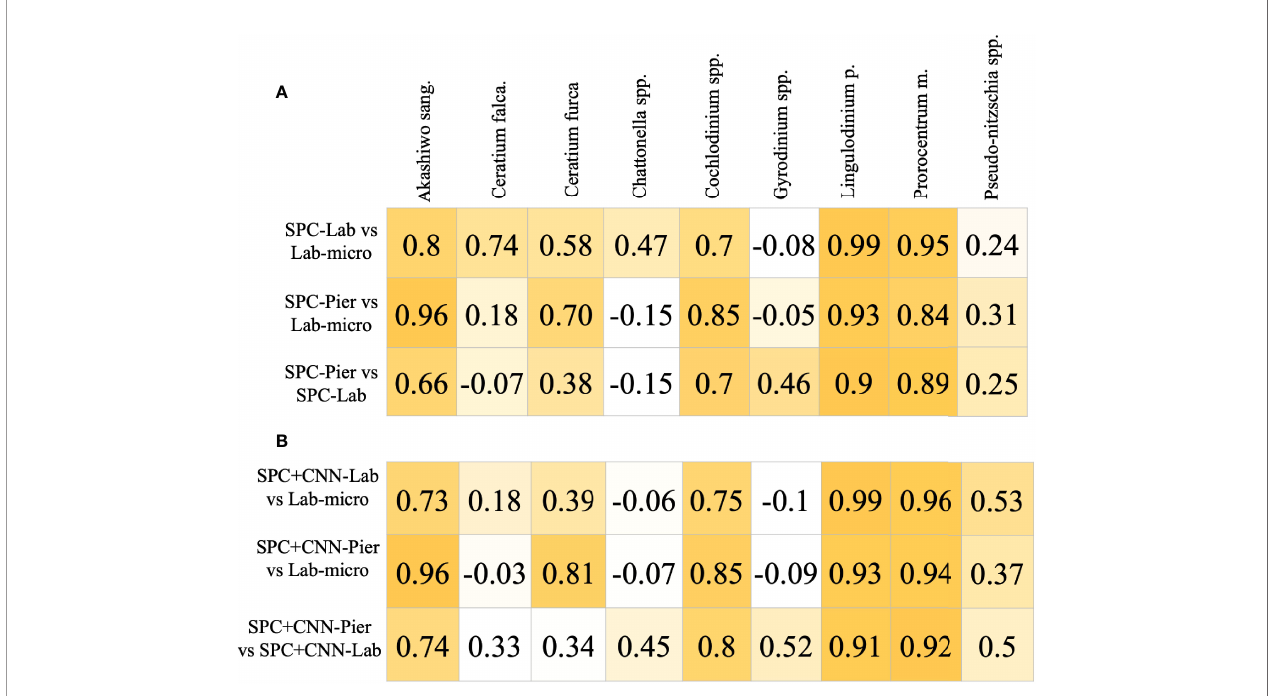
FIGURE 6 | Pearson Corre ́ lation Coef fi cient Matrices. Each row compares two of the resultant data and/or CNN estimation of taxonomic presence. Each column is a corresponding species. Coef fi cient values are color coded with respect to the species correlation value of the compared setting, in an ascending fashion. (A) Correlation of Lab-micro vs. manually enumerated SPC counts. (B) Correlation of Lab-micro vs. SPC+CNN